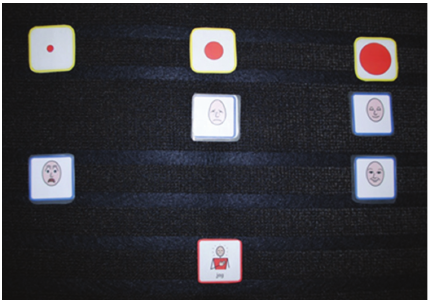
Figure 3: The modified short State-Trait Anxiety Inventory (STAI) using a modified Talking Mats